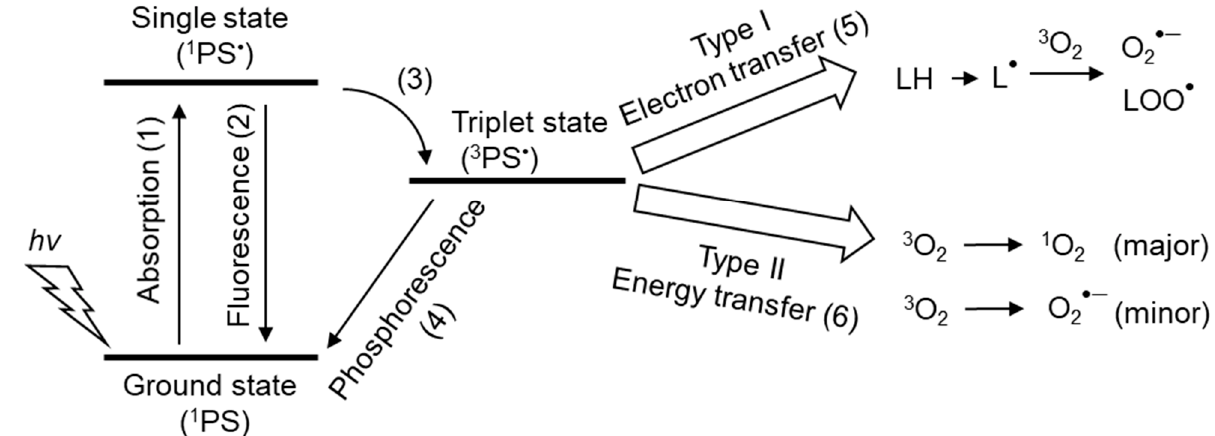
Figure 7. Photosensitizers and the mechanisms of 1 O 2 production. (1) Photosensitizers (PS) absorb photons ( hv ) from light and transform them to the excited singlet state ( 1 PS • ). (2) 1 PS • returns to the ground singlet state ( 1 PS) by